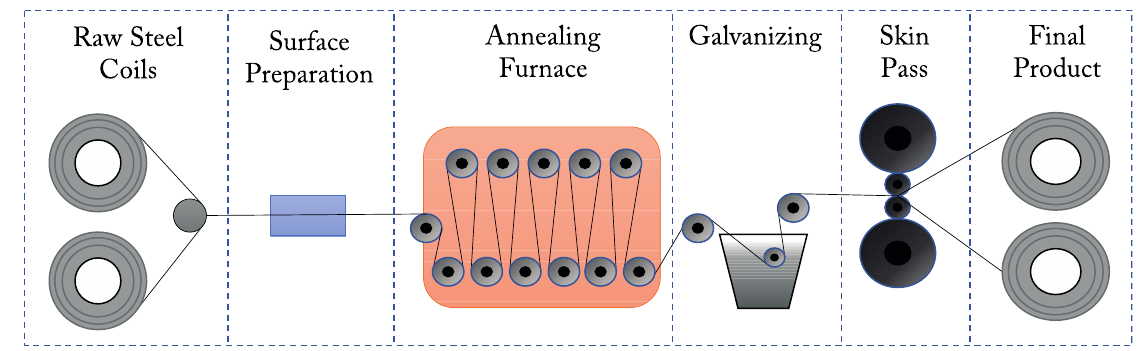
Figure 1. Representation of a hot dip galvanizing process. The zinc bath consists of a molten alloy of Zn in a bath, which is kept at 460 ◦ C by the action of two heating inductors located at the bottom of the bath. Figure 2 schematically shows the operation of the zinc bath. The bath temperature is measured as an average of the local temperatures provided by the thermocouples Ta, Tb and Tc. The inductors heat from the bottom of the bath and a natural flow inside the bath is produced so that the bath achieves the targeted